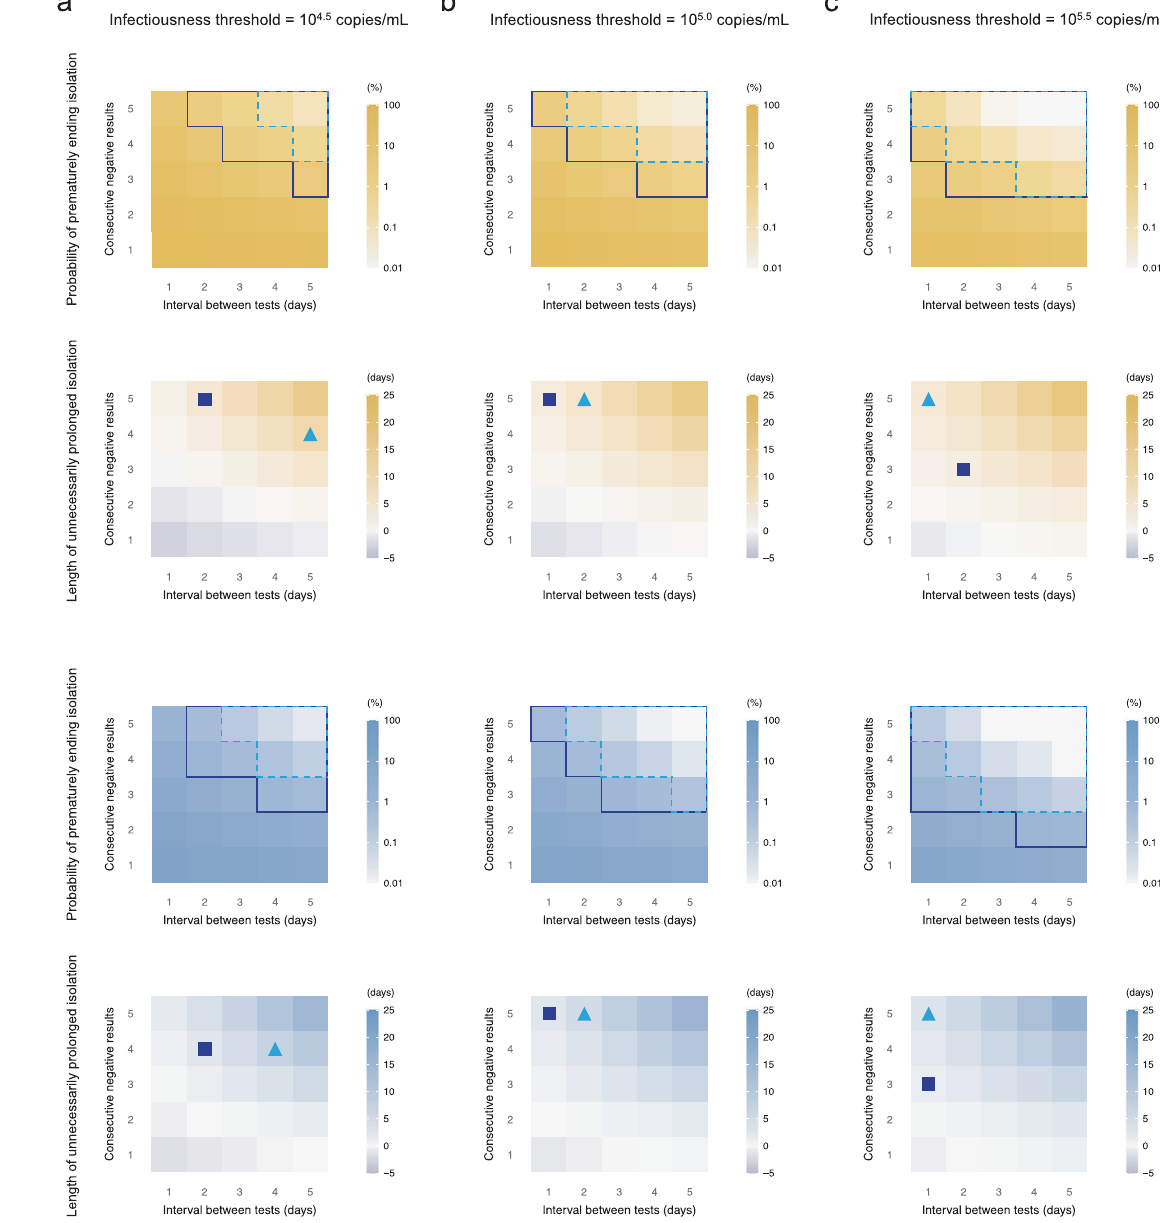
Fig. 3 | Optimal isolation guideline for symptomatic and asymptomatic cases using antigentest (detectionlimit=10 6 copies/mL). a Probability of prematurely ending isolation (upper panels) and mean length of unnecessarily prolonged iso- lation (lower panels) for different values of the interval between antigen tests and thenumberofconsecutivenegativeresultsnecessarytoendisolationforeachcase; the infectiousness threshold value is set to 10 4.5 copies/mL. The areas surrounded bysky-blue dotted linesand bluesolid linesarethose with1%or5% orlowerof risk of prematurely ending isolation of infectious patients, respectively, and the